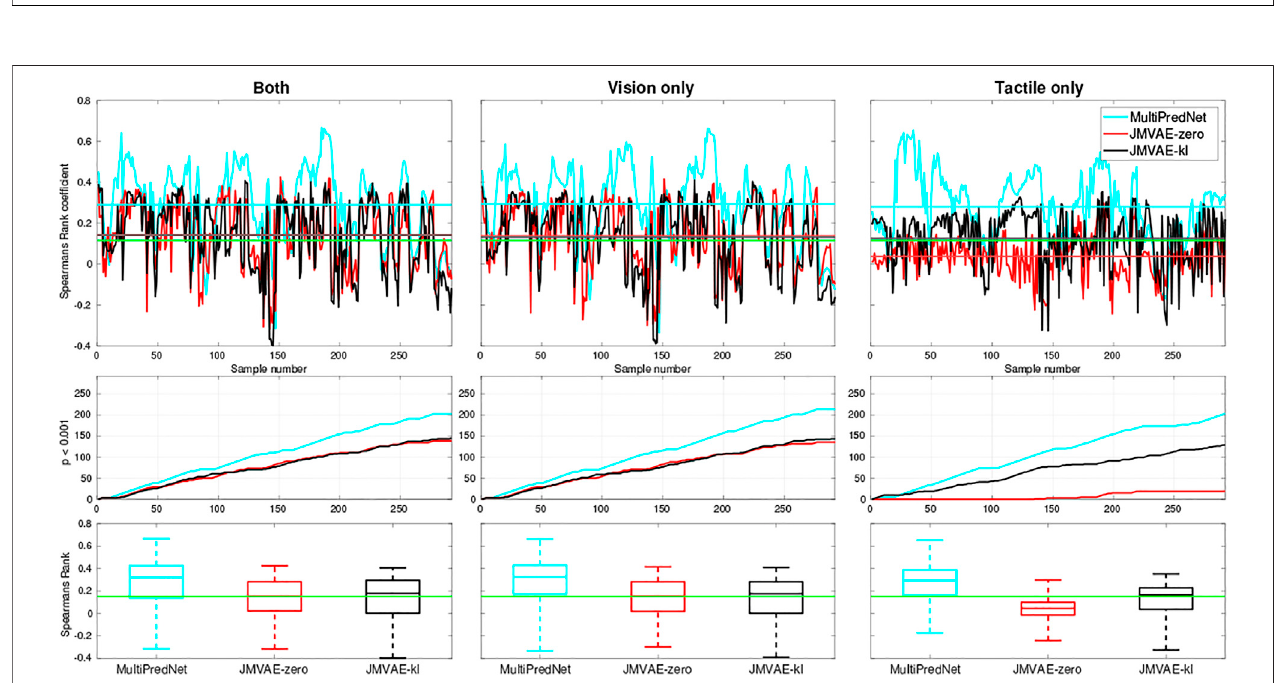
FIGURE 7 | Spearman ’ s Rank correlation coef fi cient ( ρ ) to measure performance at place recognition by 3 trained models across all four physical test sets when both sensory modalities are available (left column) , only vision available (middle column) and only tactile available (right column) . The top row of panels trace ρ with the coloured horizontal lines indicating the mean value for each model and green line indicating signi fi cance ( p < 0.001, N (cid:1) 292). The middle row of traces show the cumulative number of samples across the test set that scored an above chance positive correlation in each of the sensory conditions. The statistics for ρ across each model is distilled into boxplots in the bottom row, again with the green line indicating signi fi cance.